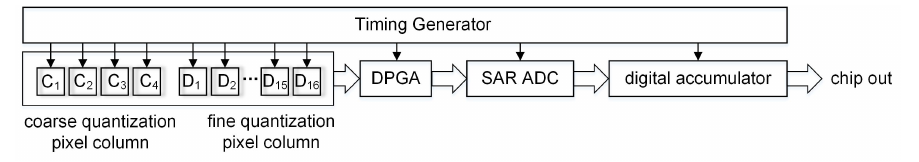
Figure 7. It consists of a pixel column, a DPGA, a 10-bit SAR ADC and a digital accumulator. The pixel column consists of a coarse quantization pixel column and a fine quantization pixel column.